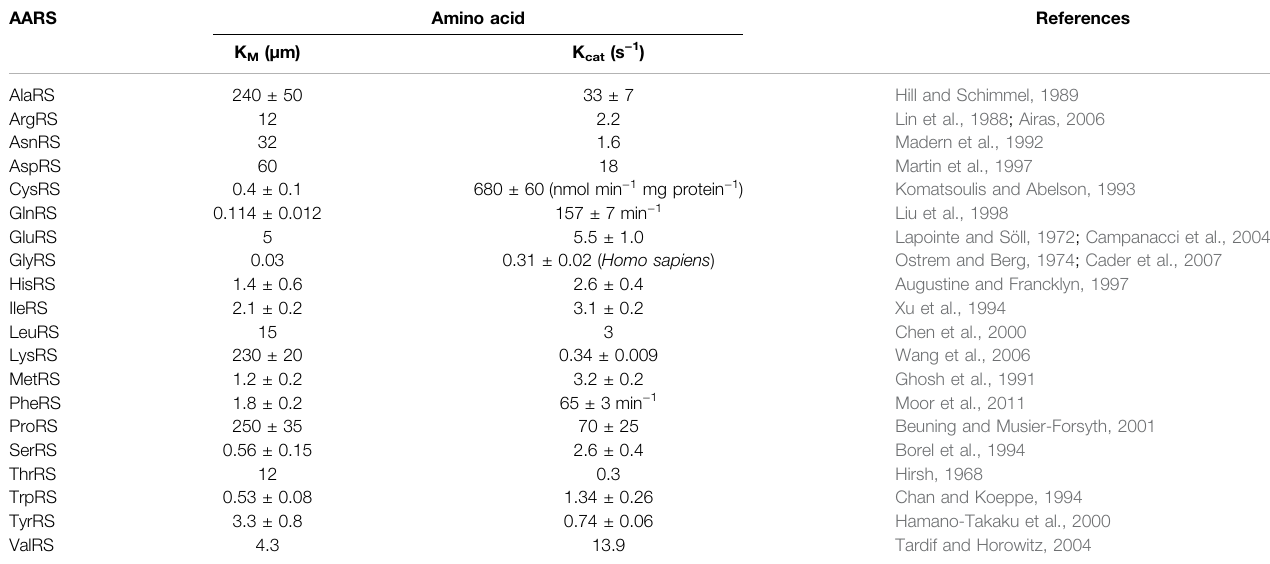
TABLE 2 | K M and K cat values of amino acids for AARS from E. coli unless mentioned otherwise. Unit for K cat is s − 1 unless mentioned otherwise. AARS Amino